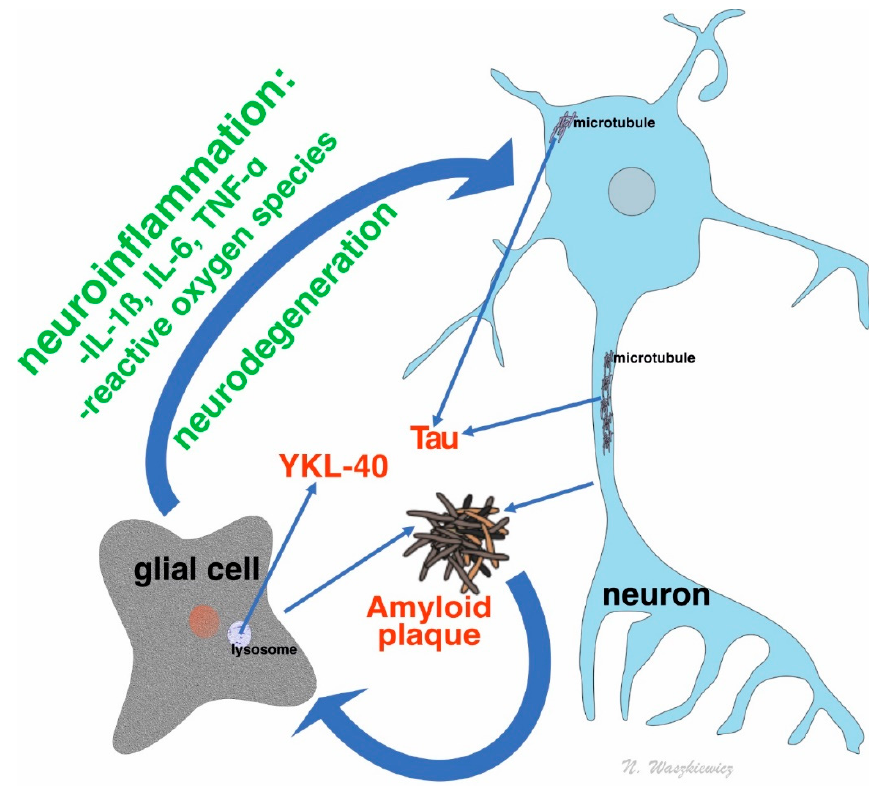
Figure 1. The role of neuroinflammation and neurodegeneration processes in the formation of dementia protein biomarkers, i.e., amyloid, tau, and YKL-40. IL-1b, interleukin 1 beta; IL-6, interleukin 6; TNF-a, tumor necrosis factor alpha.